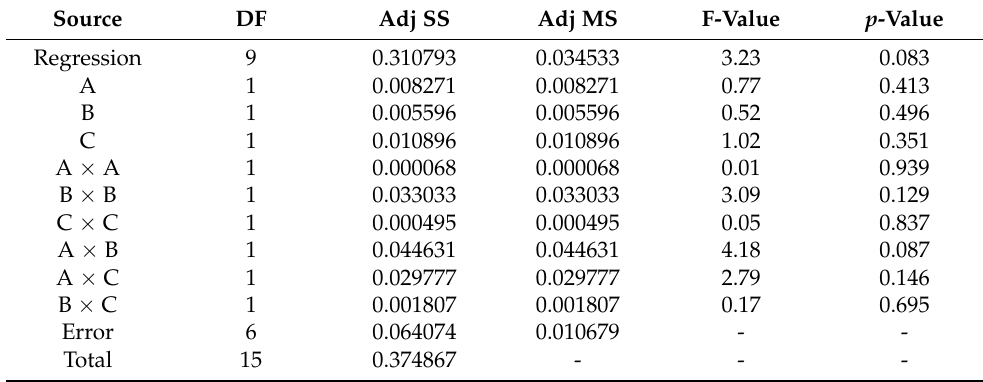
Table 10. ANOVA results obtained for corresponding GFRG